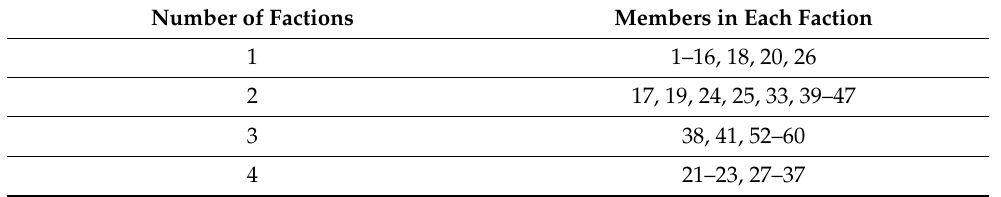
Table 3. Factional analysis of Guanxi-circle .